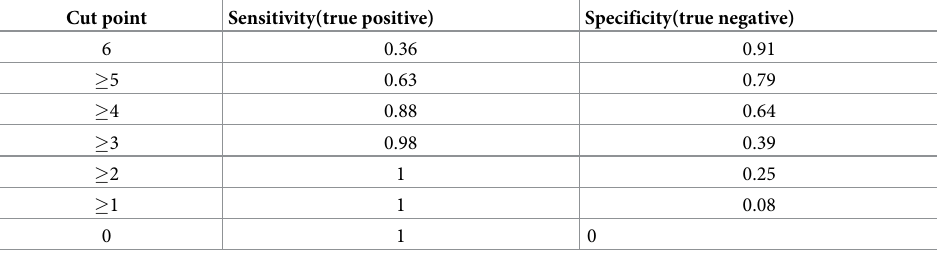
Table 3. Optimal cut-off points for prediction of adequate health